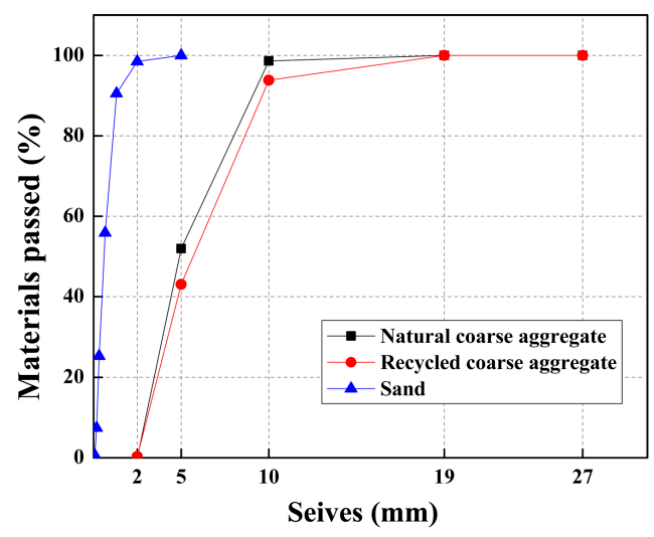
Figure 1. Grading curves of the aggregates used. Table 3. The properties and chemical compositions of granulated blast furnace slag (GGBS), fly ash, and ordinary Portland cement (OPC). (Reproduced from the previous work [46] with permission from Elsevier).